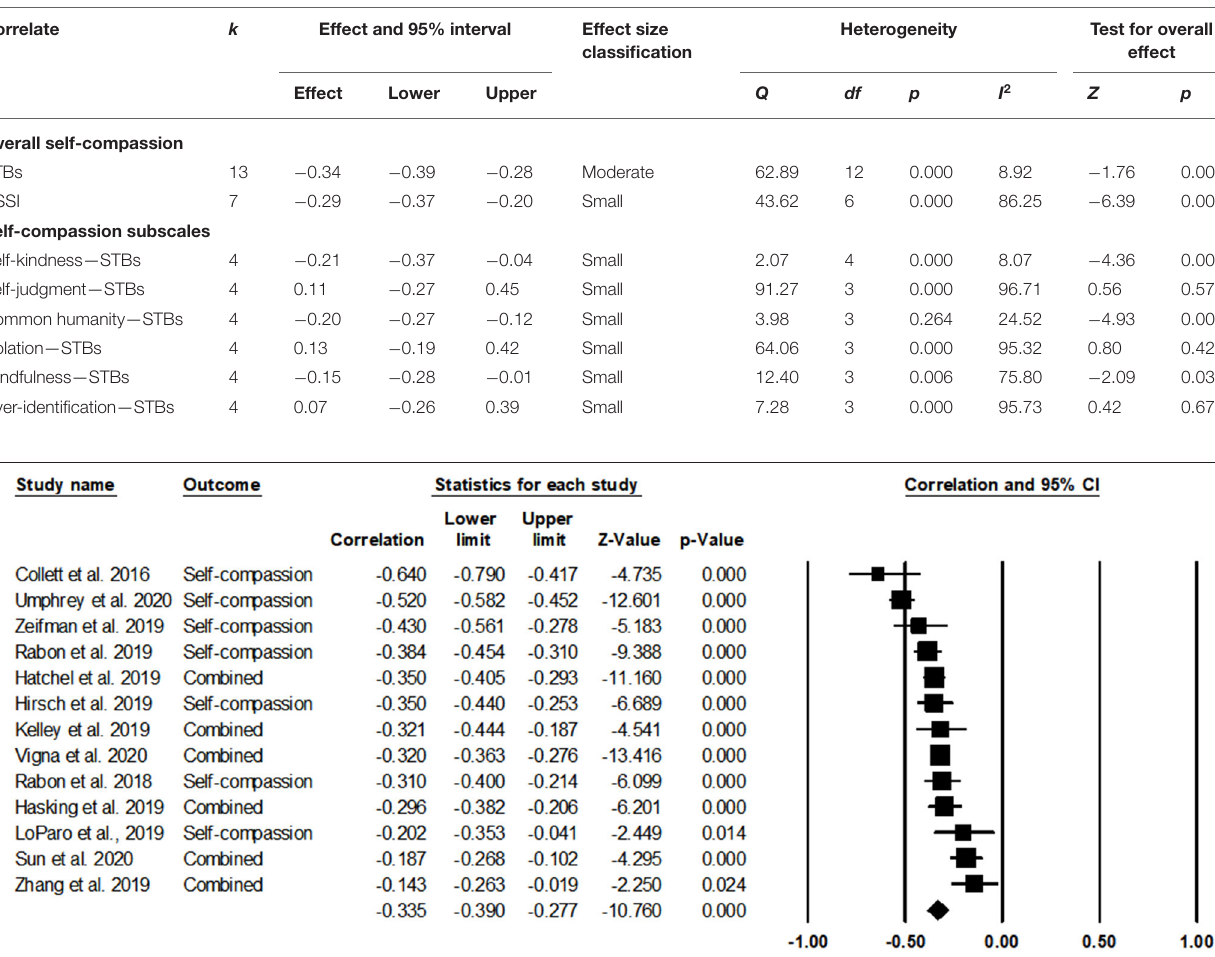
FIGURE 2 | The association of self-compassion with suicidal thoughts and behaviors